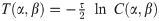
UPGMA tree obtained from the genealogical distances T(α,β)=-τ2lnC(α,β).The value of the characteristic time τ is chosen between 5027 and 5245 years according to the analysis of subsection 3.2. This choice implies a distance from the root to leaves between 1338 and 1396 years. Accordingly, the founding event (landing of the Asian ancestors and relative start of the diversification of varieties) remains fixed around 650 CE.